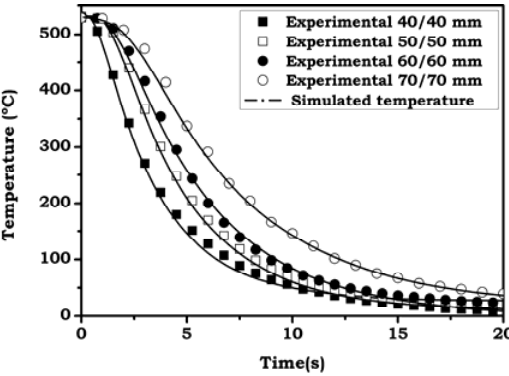
Figure 9. Predicted cooling curves and experimental ones obtained for solid cylinders of different dimensions.